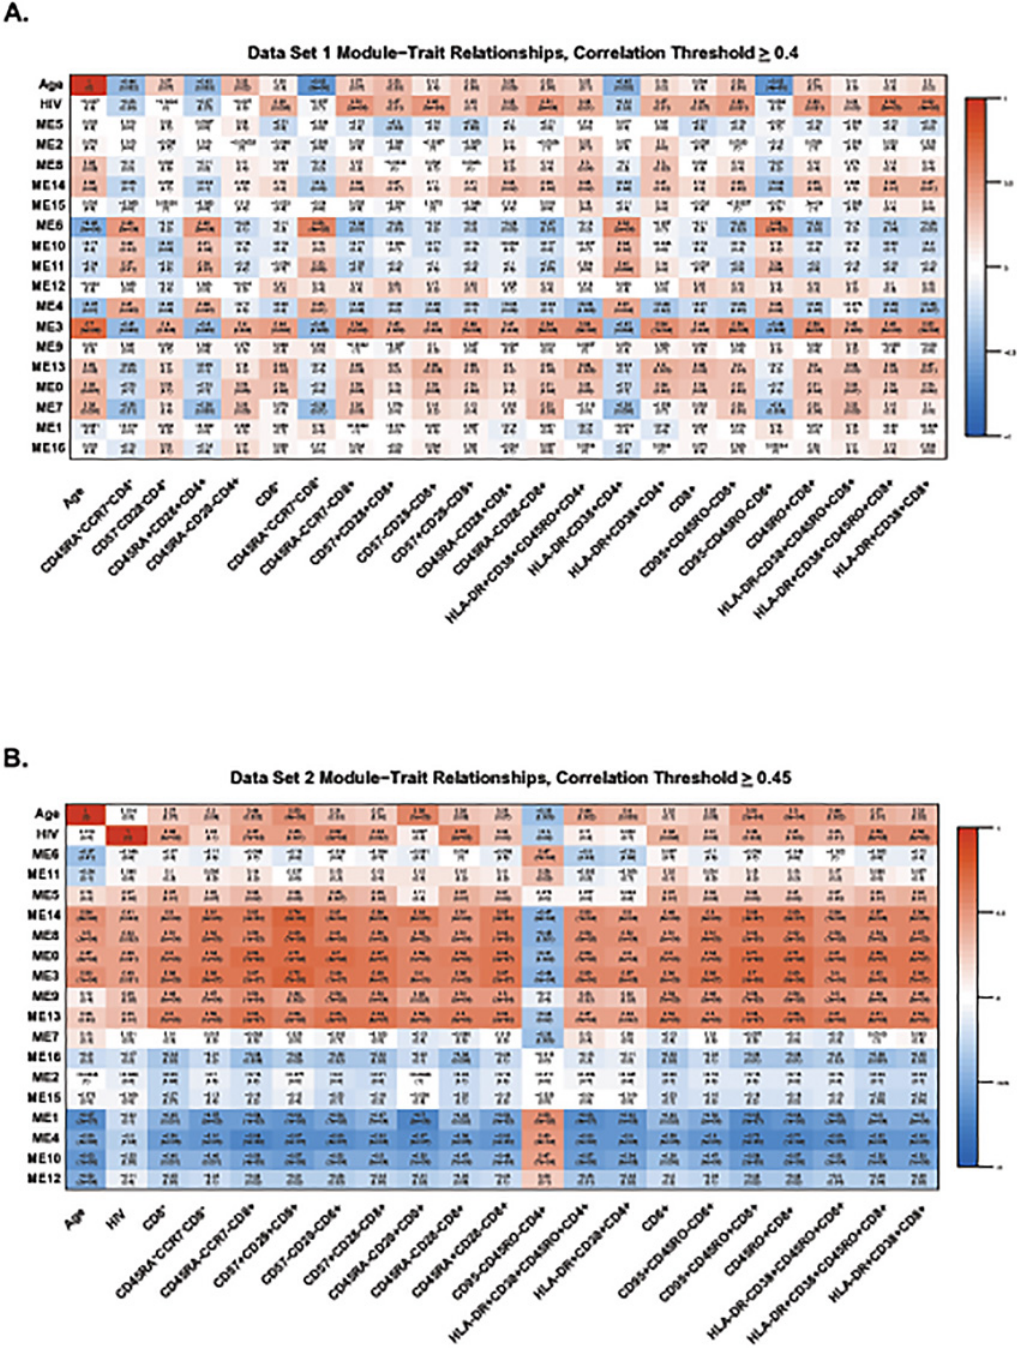
Fig 3. Heat map of module-trait relationships. This heat map shows correlations between HIV status, chronological age, and the co-methylation module (represented by their eigenvectors) for data set one (A) and data set two (B). Included are cell subsets whose absolute numbers have an absolute correlation with module 3 that was (cid:1) 0.4. Red depicts a positive correlation, blue depicts a negative correlation, as indicated by the color band on the right.